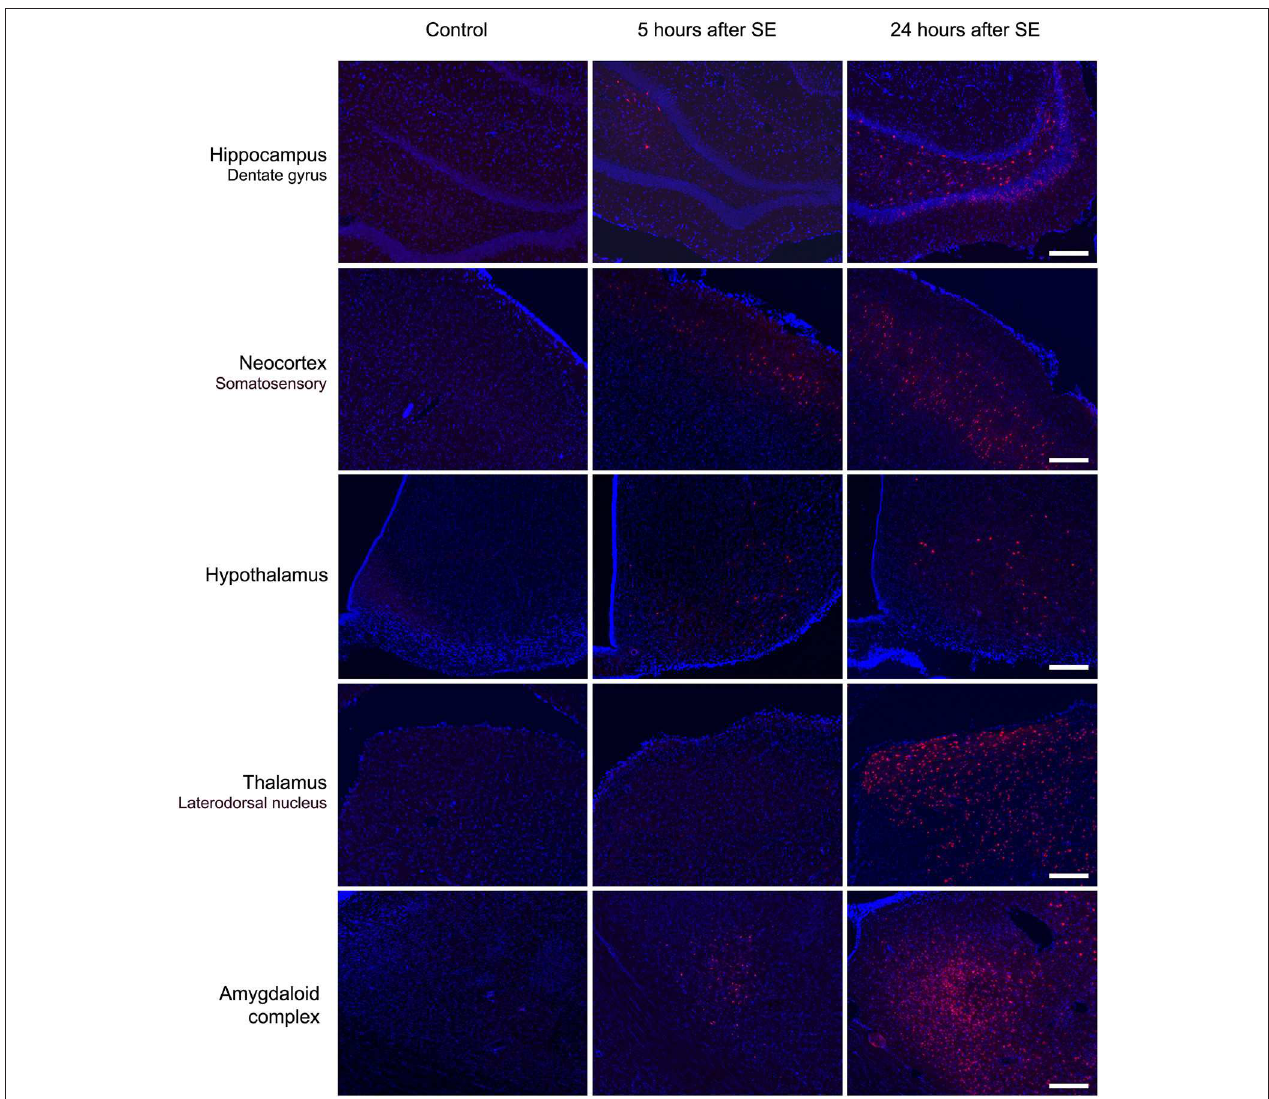
FIGURE 5 | Brain areas affected by BBB breakdown to EB dye in the acute phase of the pilocarpine-induced epilepsy model. Representative photomicrographs obtained under a fluorescence microscope show the main brain areas affected by BBB breakdown: hippocampus, neocortex, hypothalamus, thalamus, and amygdala. Cells containing the Evans blue (EB) fluorescent dye appear as red. Nuclei of the cells evidenced with DAPI are blue. Note that, in the Control group, the cells do not contain EB dye, while in group SE5hEB, there are considerably fewer cells that captured EB than in group SE24hEB, where they are widely distributed into the brain areas analyzed. Magnification: 100X. Bar = 200 µ